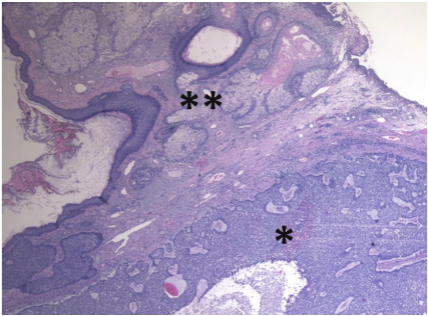
Figure 2: Basal cell carcinoma adjacent to rhinophyma in nasal skin—there are cystic nests of hyperchromatic and uniform basaloid cells( ∗ )withperipheralpalisadingsurroundedbyloosestromaclose to highly hypertrophic sebaceous glands ( ∗∗ ), typical of rhinophy-